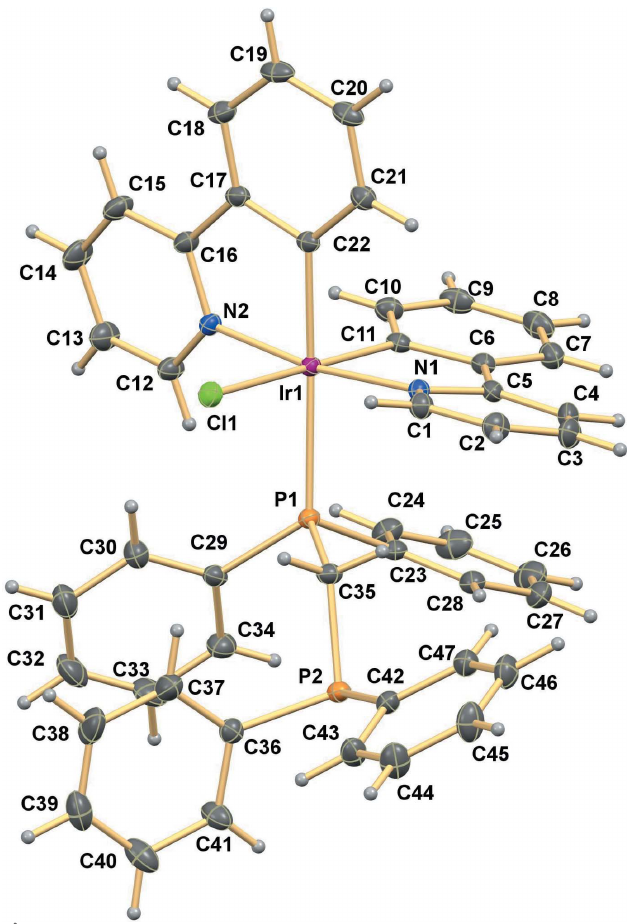
Figure 2 Intramolecular (cid:3) – (cid:3) interactions occurred between the phenyl rings of the complex (H atoms are